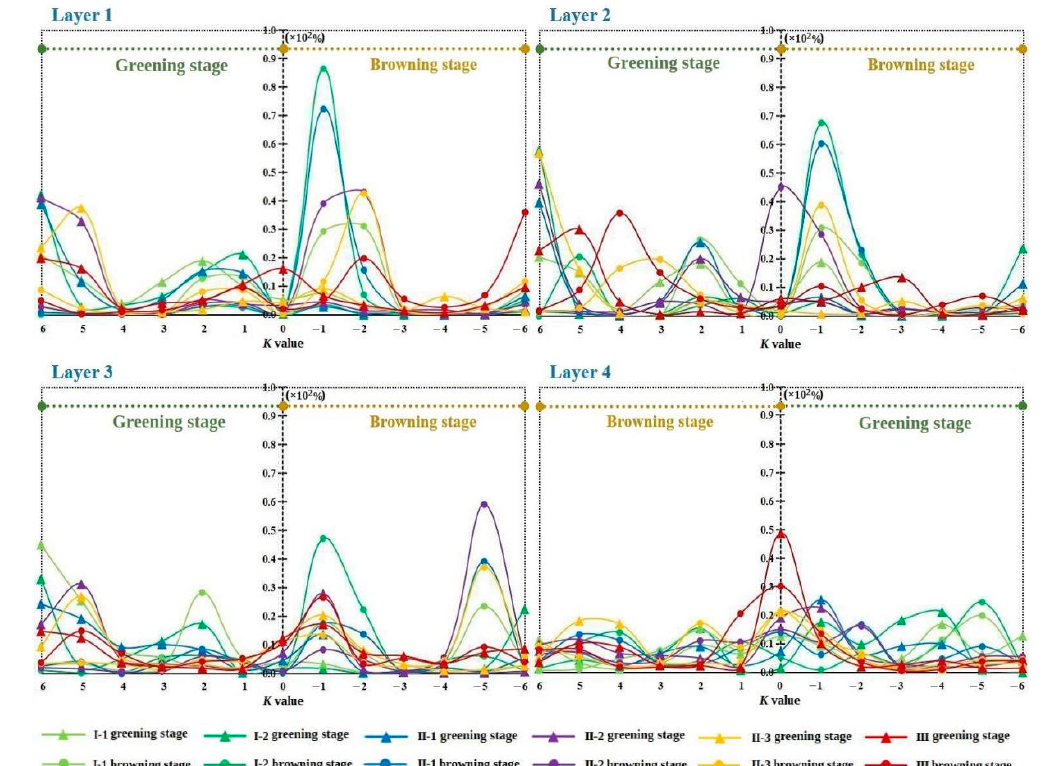
Figure 8. Pixel number proportion of the time lag between the NDVI and soil moisture at various depths during the different stages of vegetation change (Note: the positions of the greening and browning stages are in accordance with the pixel number proportions).